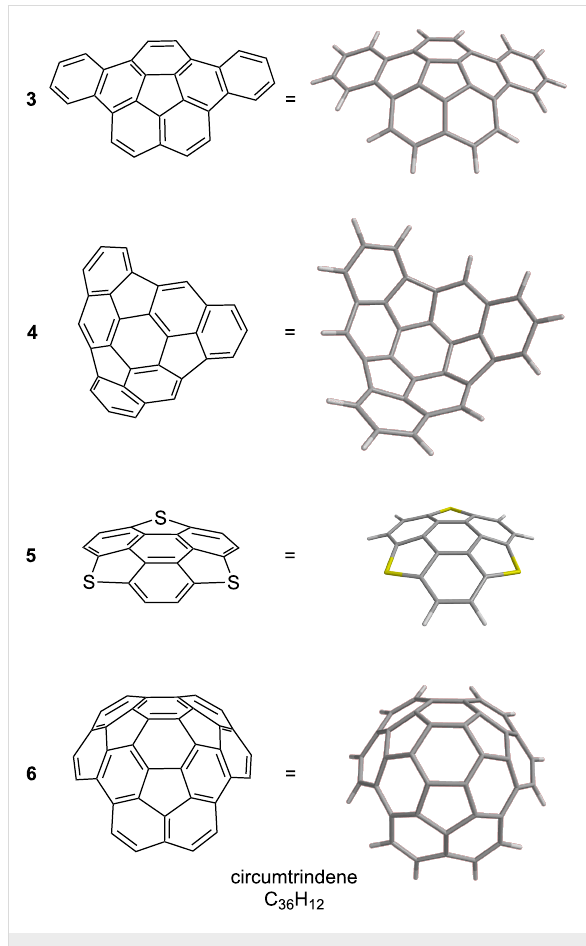
Figure 3: Selected examples of geodesic polyarenes synthesized by